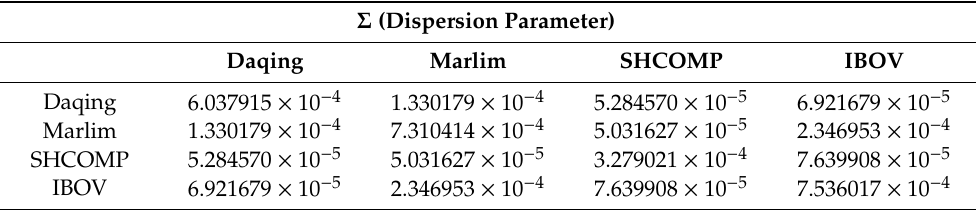
Table A15. MNIG Dispersion parameter Σ for Vector 4: Daqing, Marlim, SHCOMP, IBOV.